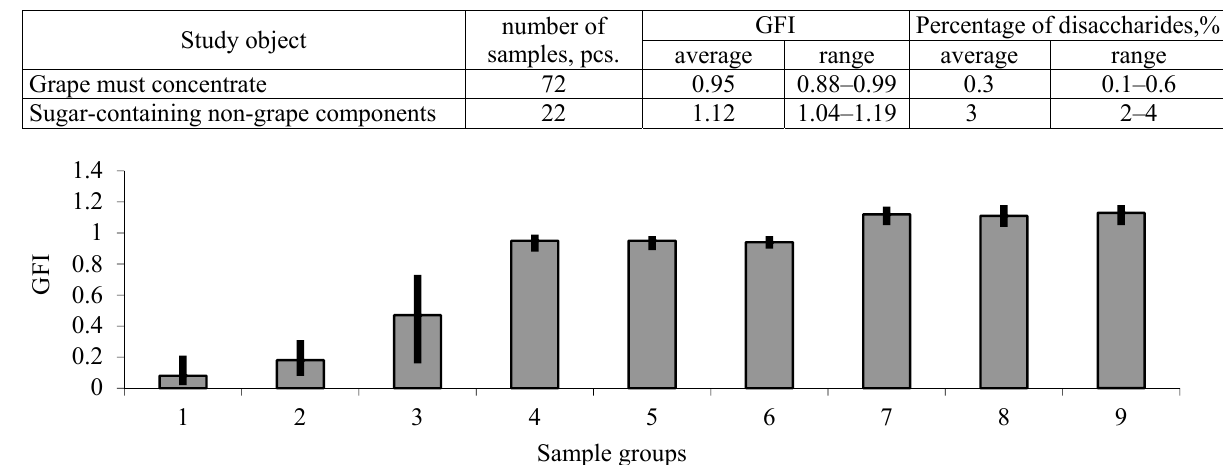
1 Table 3. Profile of sugars in various sweetening components